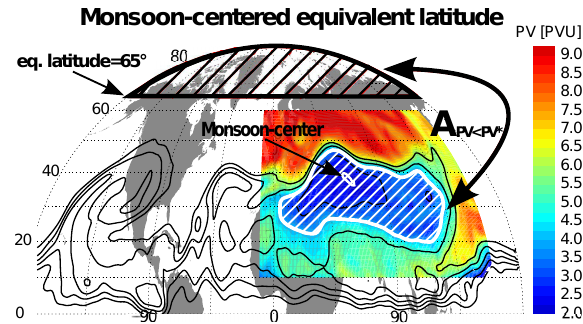
Figure 4. Illustration of the calculation of monsoon-centered equiv- alent latitude from the area within PV-contours (see text for details). Color-coded is the PV-field within the Asian monsoon region at 380K (10–60 ◦ N and 10 ◦ W–160 ◦ E) averaged for 5–7 July 2011, with the thick white contour highlighting 4PVU. The thin white contour encloses the region of lowest PV ( < 2.2PVU) indicating the anticyclone center. The black contours show PV